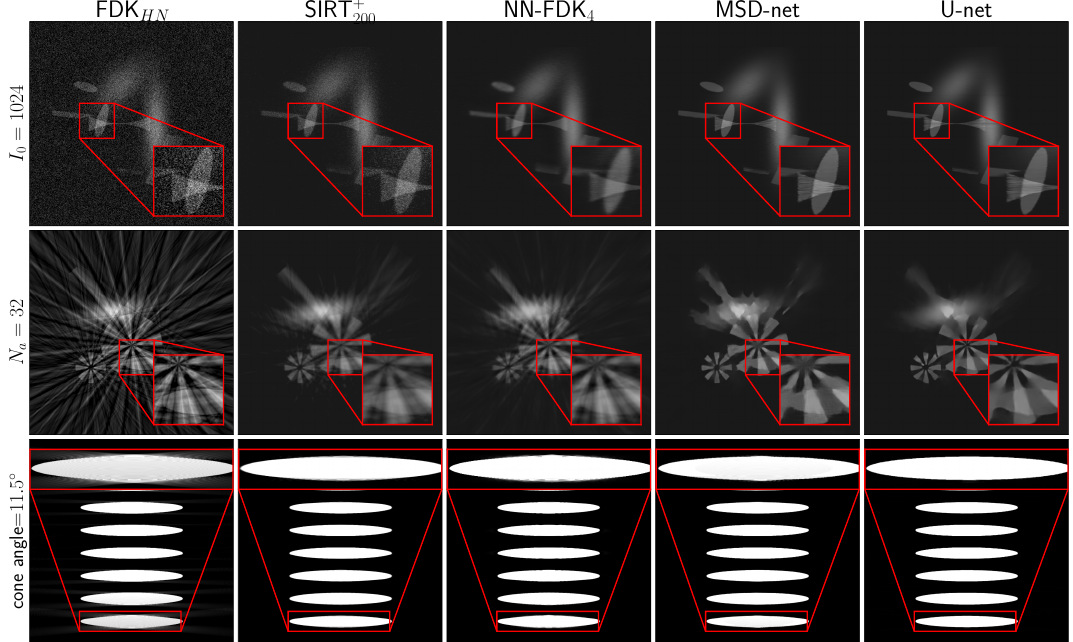
Figure 8. Two-dimensional slices of the reconstructions for the considered reconstruction methods. (Top) Slice x = 0 of the Fourshape test phantom reconstruction problem with N a = 360 projection angles and I 0 = 1024 emitted photon count. (Middle) Slice z = 0 of the Fourshape test phantom reconstruction problem with N a = 32 projection angles. (Bottom) Slice x = 0 of the Defrise reconstruction problem with N a = 360 projection angles and a cone angle of 11.5